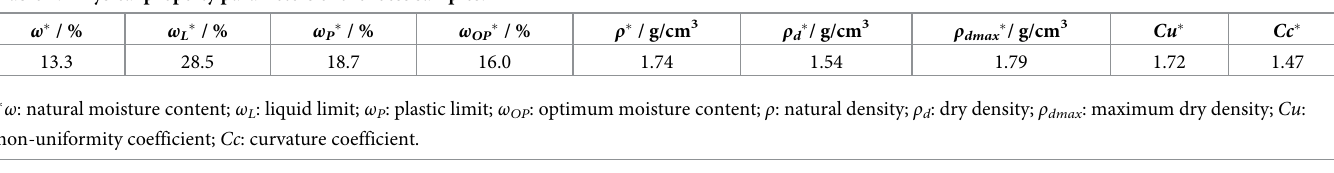
Table 1. Physical property parameters of the loess